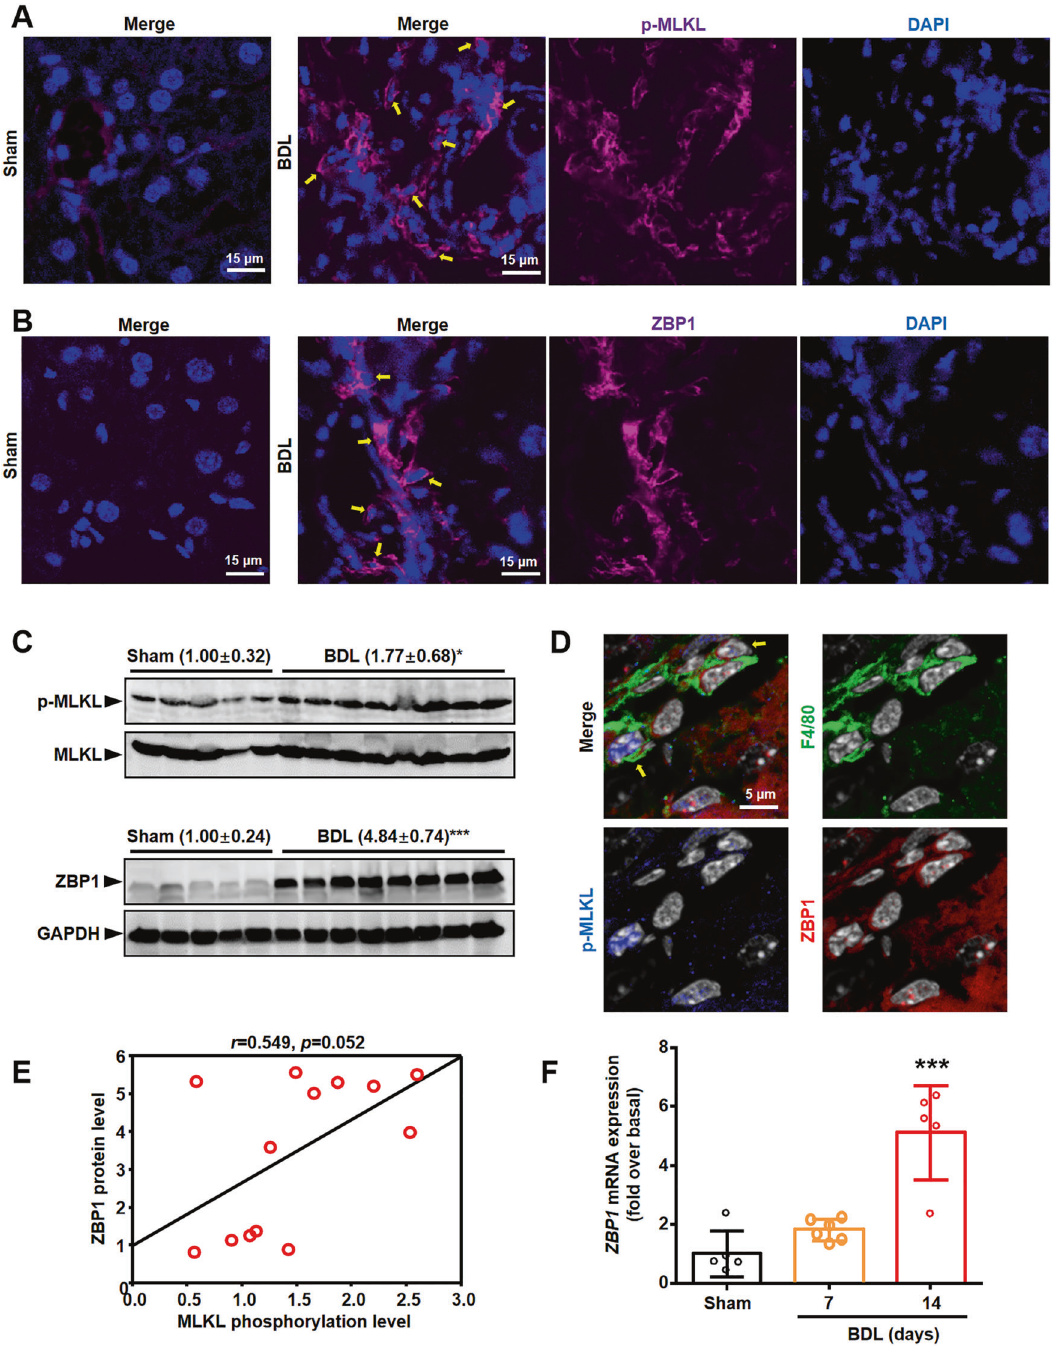
Fig. 3 Necroptosis existed in BDL livers. A Representative images of p-MLKL (pink) staining. The nuclei were stained with DAPI (blue). Yellow arrows: p-MLKL + cells. Scale bar: 15 μ m. B Representative images of ZBP1 (pink) staining. The nuclei were stained with DAPI (blue). Yellow arrows: ZBP1 + cells. Scale bar: 15 μ m. C Western blot analysis for p-MLKL and ZBP1 in the liver tissues from BDL ( n = 8) and Sham mice ( n = 5). Bolts of p-MLKL were normalized to MLKL. Blots of ZBP1 were normalized to GAPDH. D Representative images of F4/80 (green), ZBP1 (red) and p-MLKL (blue) staining in BDL livers. The nuclei were stained with DAPI (white). Yellow arrows: p-MLKL + ZBP1 + F4/80 + cells. E The correlation between ZBP1 and p-MLKL levels in mice liver tissues. F mRNA level of Zbp1 in mice livers was measured by qRT-PCR. Data are presented as the mean ± SEM. * p < 0.05, *** p < 0.001 (versus